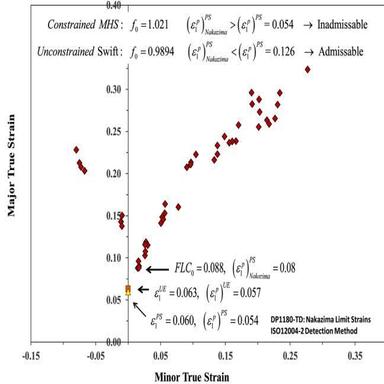
Evaluation of the hardening model and calibration procedure on the predicted FLC using the MK model using von Mises plasticity for the DP1180 steel.